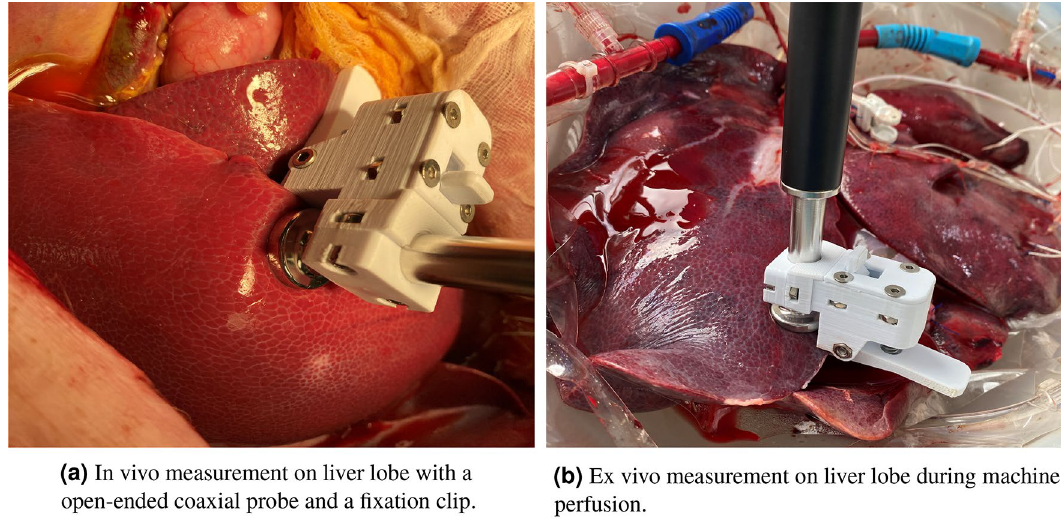
Figure 5. Experimental setup for both in vivo and ex vivo